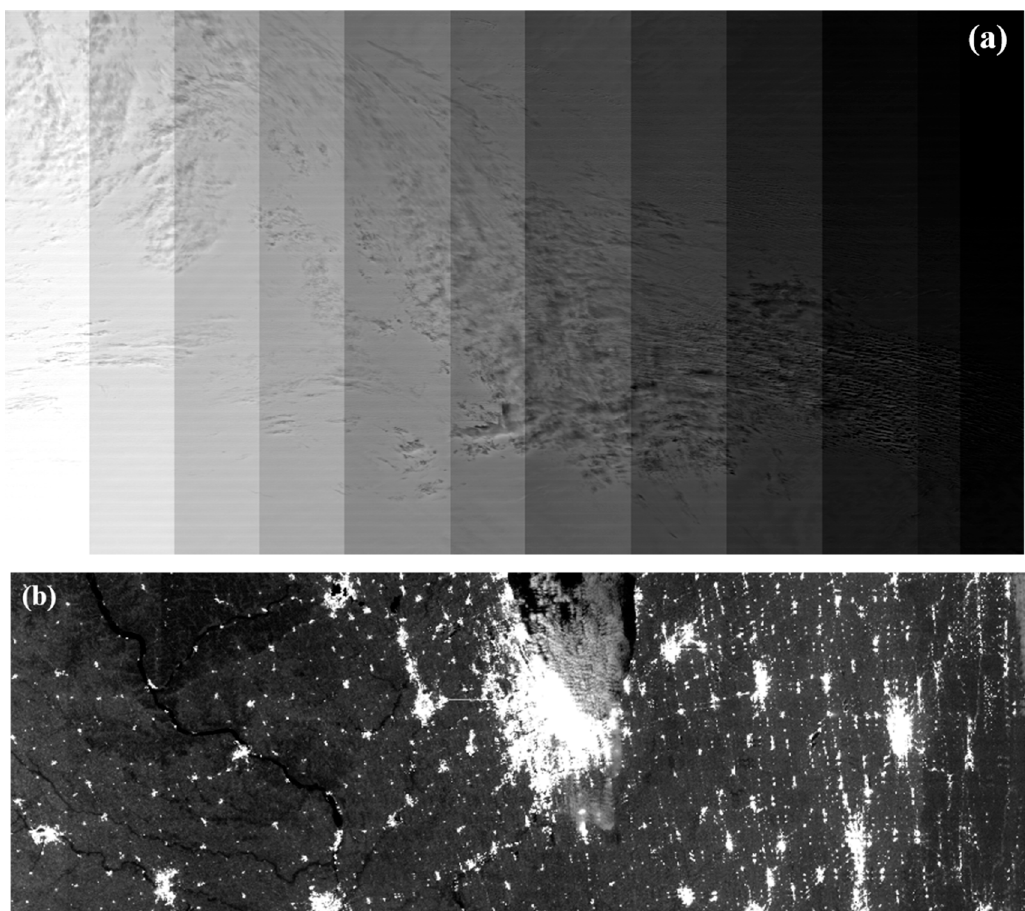
Figure 3. Gain correction free images of Figure 2. ( a ) Dark offset and RVS corrected DN image of Figure 2a. ( b ) Dark offset and RVS corrected DN image of Figure 2b.